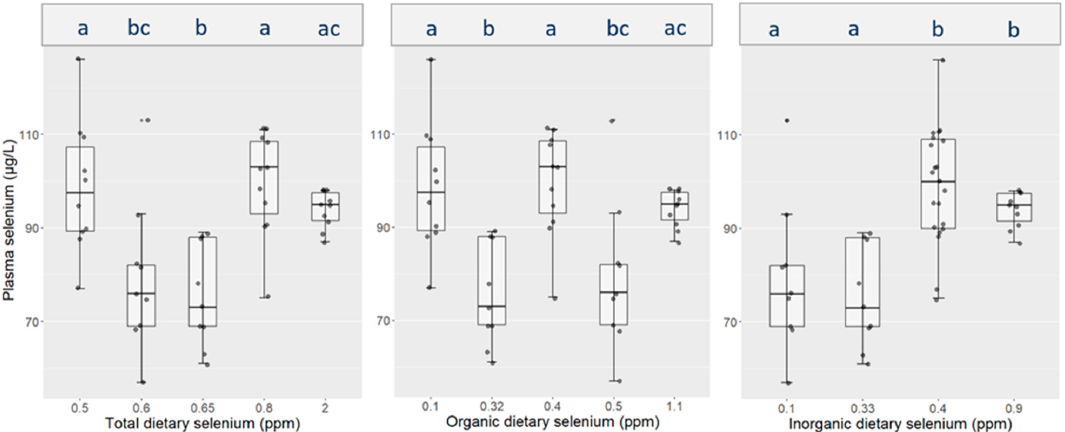
Figure 3. Boxplots and ANOVA results for plasma selenium concentration vs. dietary selenium levels. Total dietary selenium = organic + inorganic dietary selenium. Dietary selenium levels bearing different superscripts (in dark blue above the boxes) differ significantly at p < 0.05.